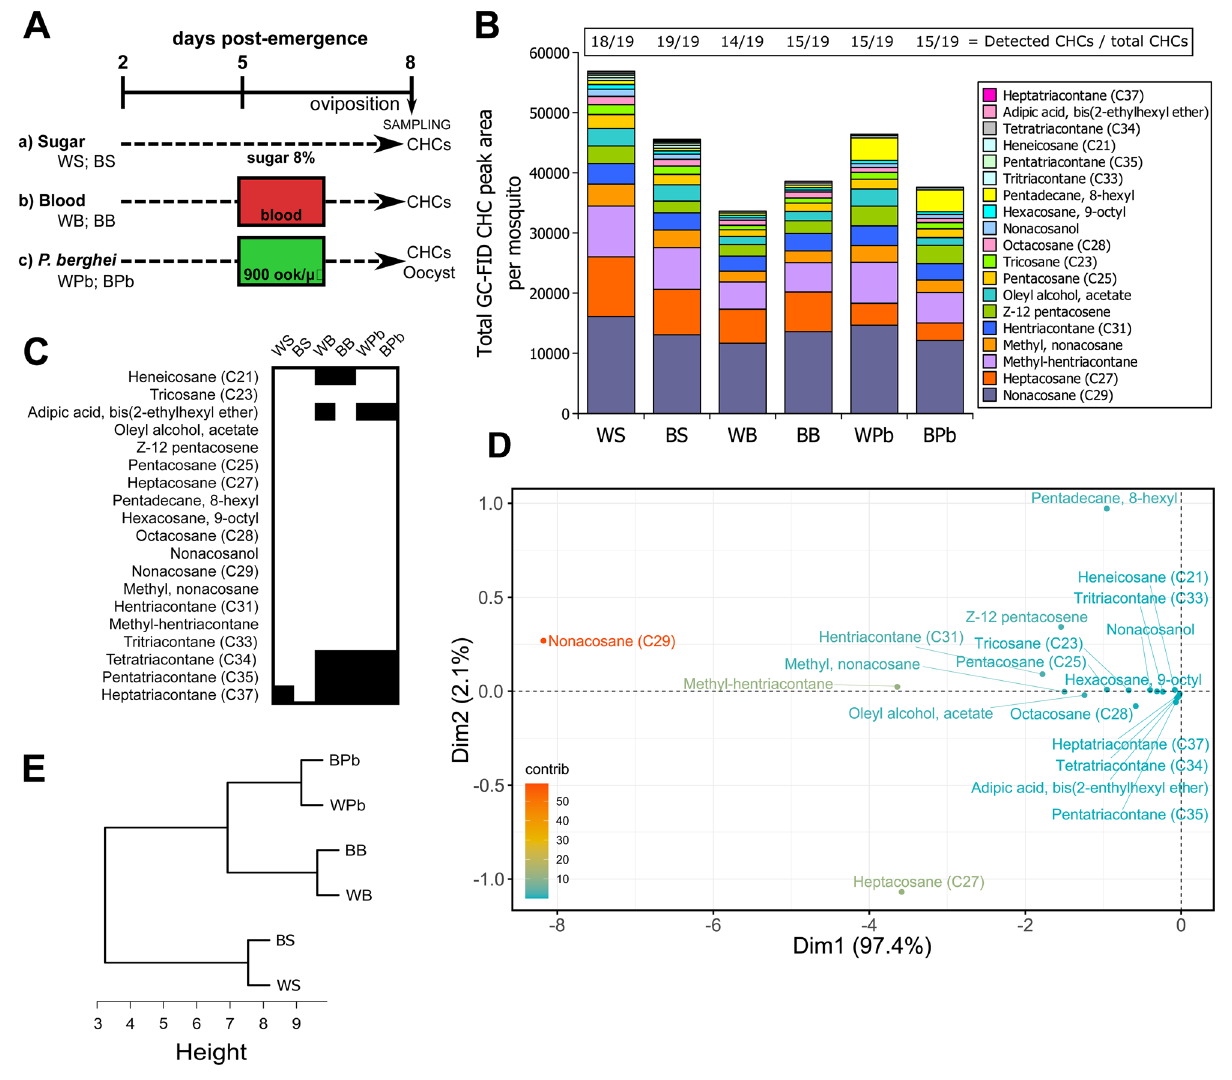
Figure 1. The composition of cuticular hydrocarbons in An. albimanus mosquito is diet and infection dependent. ( A ) Experimental setup for the determination of the CHC composition and abundance in the susceptible (White) and resistant (Brown) to infection phenotypes. White (W) and Brown (B) female mosquitoes were fed on 8% sucrose solution (WS; BS) for the entire experiment. Additionally, at 5 days post- emergence (dpe) mosquitoes were, blood-fed (WB; BB), or fed with 900 P. berghei ookinetes per microlitre (WPb; BPb). CHC extraction was carried out three days post feeding from 50 mosquitoes per group in triplicates for GC identification. Oocyst counts per mosquito were also determined at eight dpe. ( B ) Stacked area of each CHC per mosquito-equivalent (i.e. divided by the number of mosquitoes per sample) normalized by a heptadecane internal standard in the two phenotypes fed with different diets and Plasmodium -challenged. Results of two independent experiments performed in triplicates. The number of identified compounds per phenotype and feeding treatment are shown above each column. ( C ) Qualitative changes in the CHC profiles in the two phenotypes fed with the different diets and Plasmodium -challenged. The boxes show the presence (white) or absence (black) of the CHC in the mosquito extracts. ( D ) Principal component analysis (PCA) of the mosquitoes’ CHC profiles fed with different diets and Plasmodium -challenged. The PCA plot indicates the influence of each CHC in explaining the variation between the phenotypes and feeding groups. The colour gradient (contrib.) indicates the percentage contribution of a compound on the variability of the data. ( E ) Cluster dendrogram of the CHC profiles per phenotype and feeding group. The PCA’s distance matrix comprised of the CHC profiles of the feeding treatments and phenotypes were analyzed to display the hierarchical relationships. The mosquitoes were clustered on basis of their feeding treatments, confirming that the diet induces greater changes in the CHC profiles than the differences the phenotypes display between each